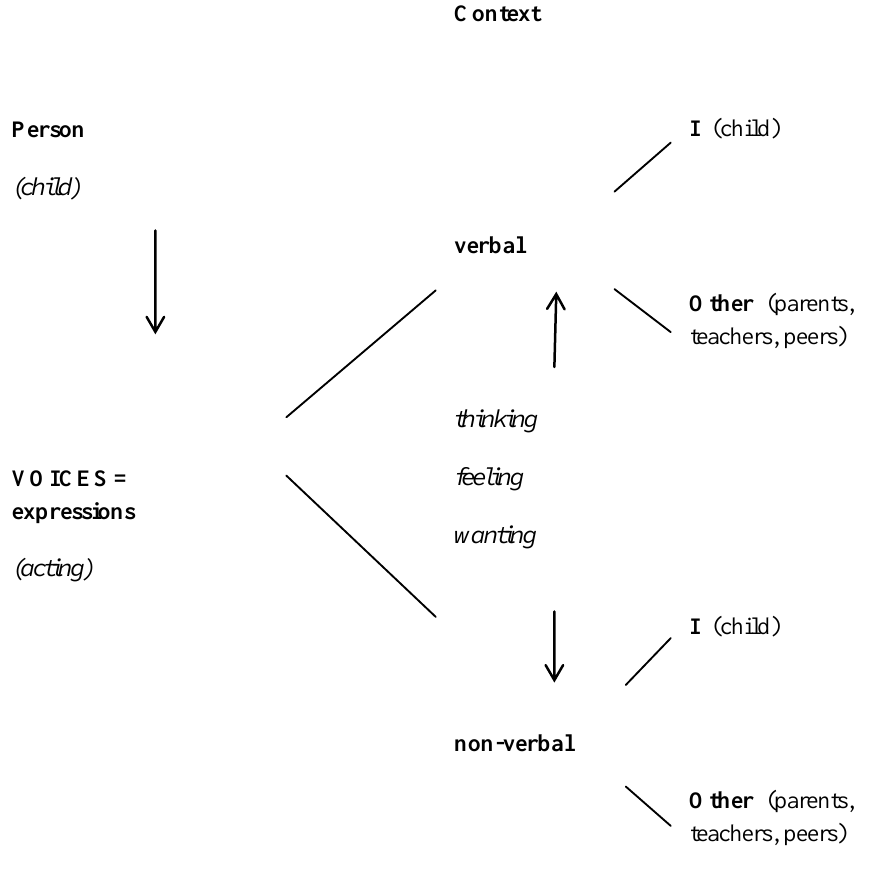
Figure 1. Conceptual framework: related elements in the construct of voice and attribution of meaning